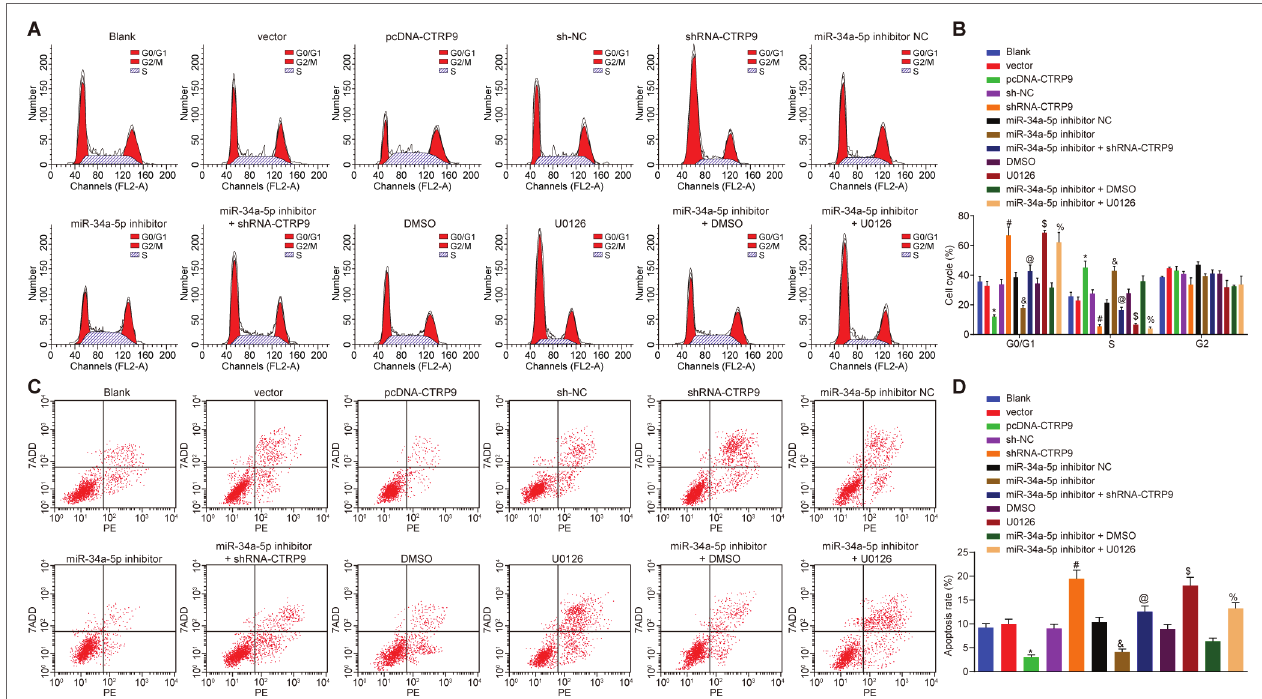
FIGURE 5 | Inhibition of miR-34a-5p suppresses ADSC apoptosis in vitro by the promotion of CTRP9 expression. (A,B) Distribution of ADSC cycles measured using flow cytometry. (C,D) ADSC apoptosis measured using Annexin V-PE/7-ADD staining with flow cytometry. * p < 0.05 vs. the vector group; # p < 0.05 vs. the sh-NC group; & p < 0.05 vs. the miR-34a-5p inhibitor NC group; @ p < 0.05 vs. the miR-34a-5p inhibitor group; $ p < 0.05 vs. the DMSO group; % p < 0.05 vs. the miR-34a-5p inhibitor + DMSO group. Data (mean ± s.d.) among multiple groups were analyzed by one-way ANOVA, followed by Tukey’s post hoc test. The experiment was repeated three times. CTRP9, C1q/tumor necrosis factor-related protein-9; miR-34a-5p, microRNA-34a-5p; ADSC, adipose-derived stem cell; sh, short hairpin; NC, negative control; DMSO, dimethyl sulfoxide; s.d., standard deviation; ANOVA, analysis of variance.